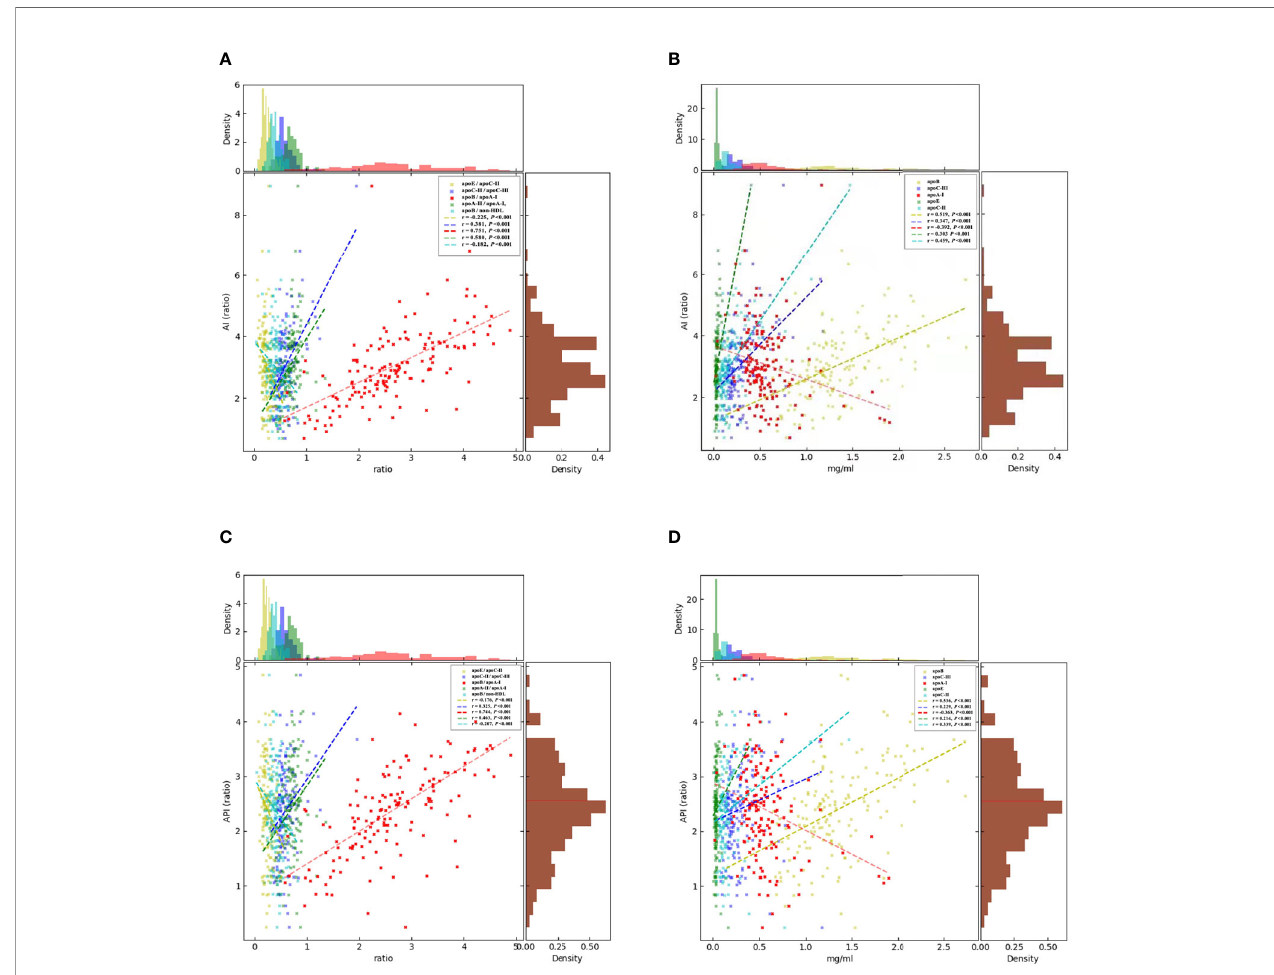
FIGURE 1 | Correlations between the circulating levels of AI, API, and the apolipoproteins by Spearman ’ s rank correlation coef fi cient analysis. (A) : apoB/apoA-I ( p < 0.001), apoC-II/apoC-III ( p < 0.001), and apoA-II/apoA-I ( p < 0.001) were positively correlated with AI. apoB/non – HDL-C ( p < 0.001) and apoE/apoC-II were signi fi cantly negatively corelated with AI. (B) : apoC-III ( p < 0.001), apoE ( p < 0.001), apoC-II, and apoB were positively correlated with AI. (C) : apoB/apoA-I ( p < 0.001), apoC-II/apoC-III ( p < 0.001), and apoA-II/apoA-I ( p < 0.001) were signi fi cantly positively correlated with API. apoB/non – HDL-C ( p < 0.001) and apoE/apoC-II were signi fi cantly negatively correlated with API. (D) : apoA1 ( p < 0.001), apoC-III ( p < 0.001), apoE ( p < 0.001), apoC-II, and apoB were positively correlated with API, but apoA-I was signi fi cantly negatively correlated with API. The brown histograms on the right side represent the data distribution of AI and API. AI,